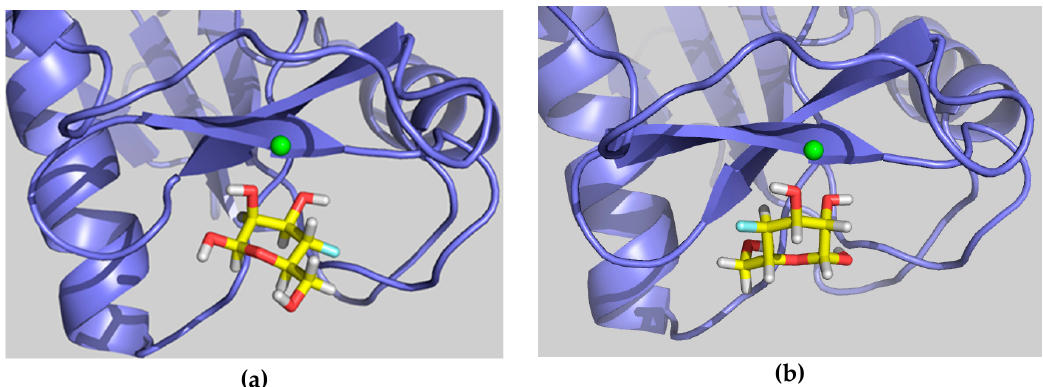
6 of 17 Figure 4. Percentage of decrease of the T 2 values for different ligand/lectin molar ratios deduced for the fluorine-containing Man moieties, as obtained from the 19 F-NMR relaxation filter experiments. The feasibility of these alternative binding modes was explored using molecular modeling procedures. In particular, two putative binding poses were initially built. The first one, binding pose A, was generated using the geometry with PDB code 1SL5 (DC-SIGN complexed to lacto- N - fucopentaose), placing the 4-F-Man moiety at the Fuc site by superimposing the OH-2/OH-3 groups of 4-F-Man with OH-4/OH-3 of Fuc (see Figure 5a and Figure 6a, with an equivalent Man molecule in this binding pose). The second one, binding pose B, was generated using the geometry with PDB